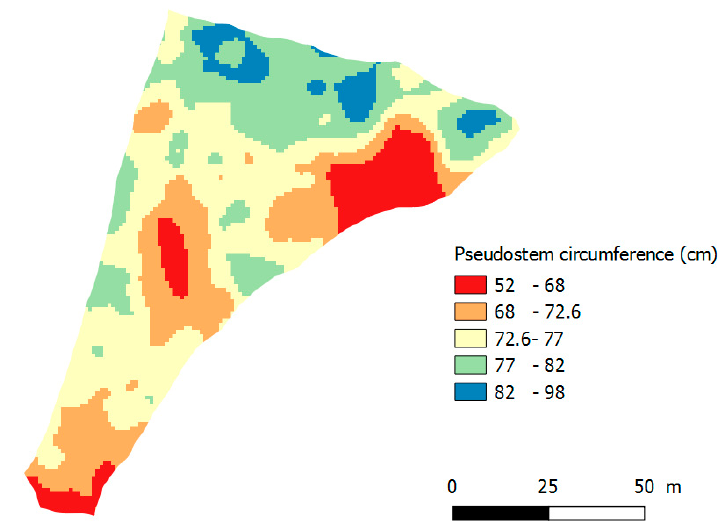
Figure 6. Kriged map of the potential pseudostem circumference within the field under study. The map represents a potential rather than an exhaustive analysis of plants because not all the plants have reached the flowering stage.